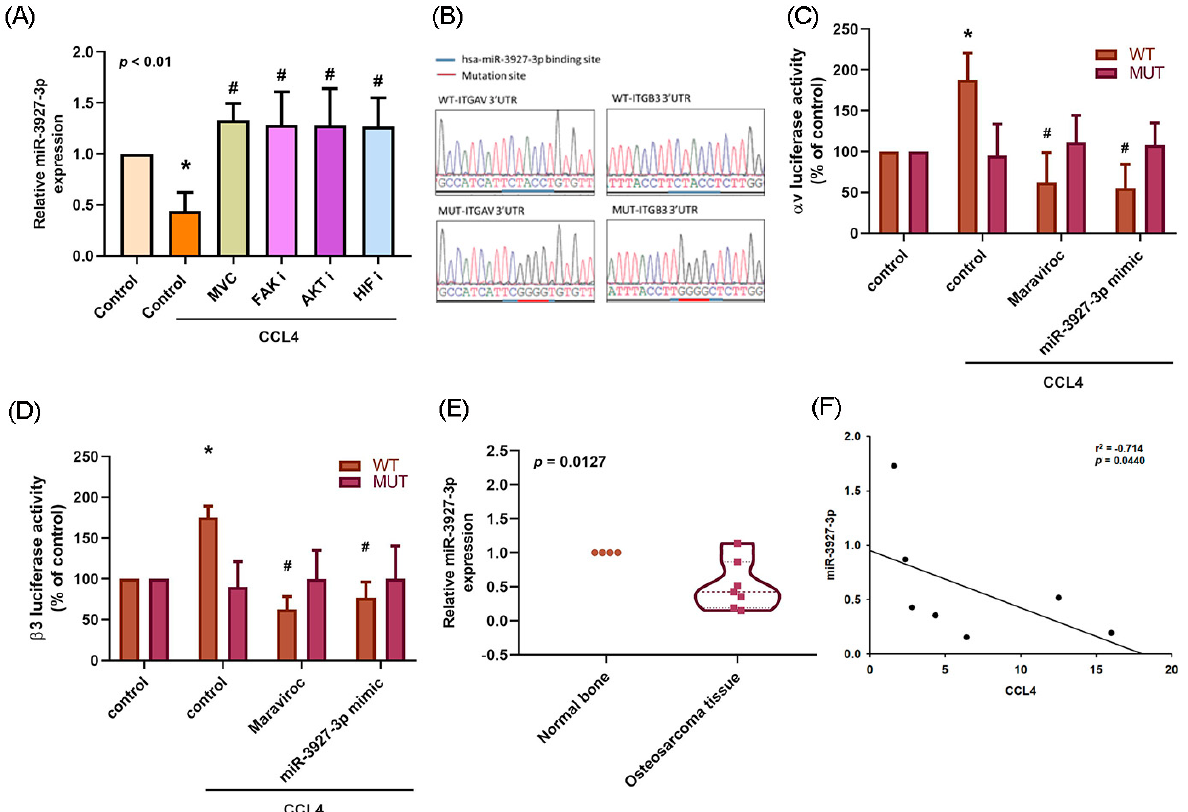
Figure 7. The FAK/AKT/HIF-1 α signaling pathway is involved in CCL4-downregulated miR-3927-3p expression. ( A ) 143B cells were treated for 30 min with a FAK i (10 µ M), AKT i (10 µ M), or HIF i (10 µ M) then incubated with CCL4 for 24 h. miR- 3927-3p expression was examined by qPCR. ( B ) The wild-type (WT) or mutant binding sites (MUT) of ITGAV and ITGB3 3 (cid:48) UTRs containing the miR-3927-3p binding site were inserted into the pmirGLO vector. ( C , D ) The WT- or MUT-3 (cid:48) UTR luciferase activities of integrin α v and β 3 were measured after MVC treatment or transfection with miR-3927-3p mimic. ( E ) miR-3927-3p expression in normal bone and osteosarcoma tissues were detected by qPCR. ( F ) Analysis of the correlation between CCL4 and miR-3927-3p expression in osteosarcoma tissue. The results were obtained from three independent experiments and are expressed as the means ± SD. * p < 0.05 compared with controls; # p < 0.05 compared with CCL4-treated controls.